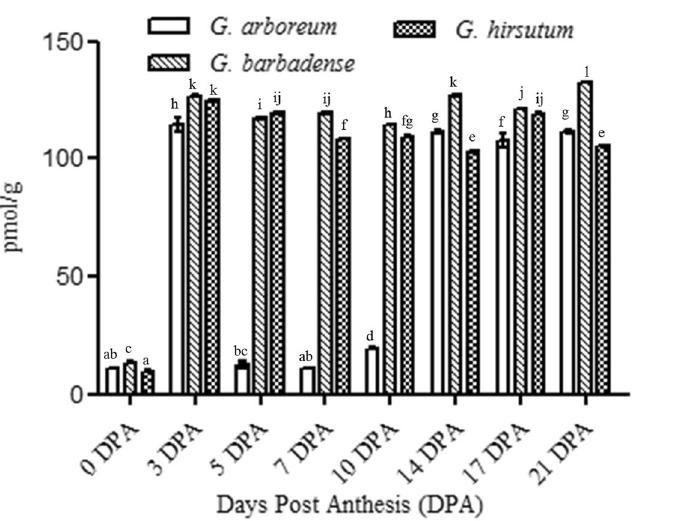
Figure 8. Endogenous 1-aminocyclopropane-1-carboxylic acid (ACC) content (pmol/g of tissue) in developing fibers through high performance liquid chromatography